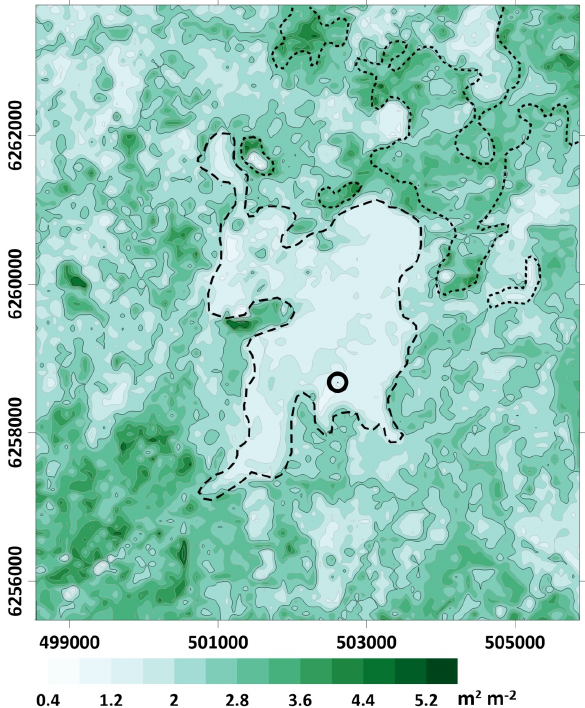
Figure 2. Spatial pattern of the leaf area index (LAI) for the selected modeling domain covering the Staroselsky Moch peatland and surrounding landscapes. The medium-dashed line shows the peatland boundary. The short-dashed line shows the boundaries of abandoned lands with grassy vegetation and open places. The black circle indicates the location of the eddy covariance flux station. The coordinate system is Universal Transverse Mercator (UTM, 36N).